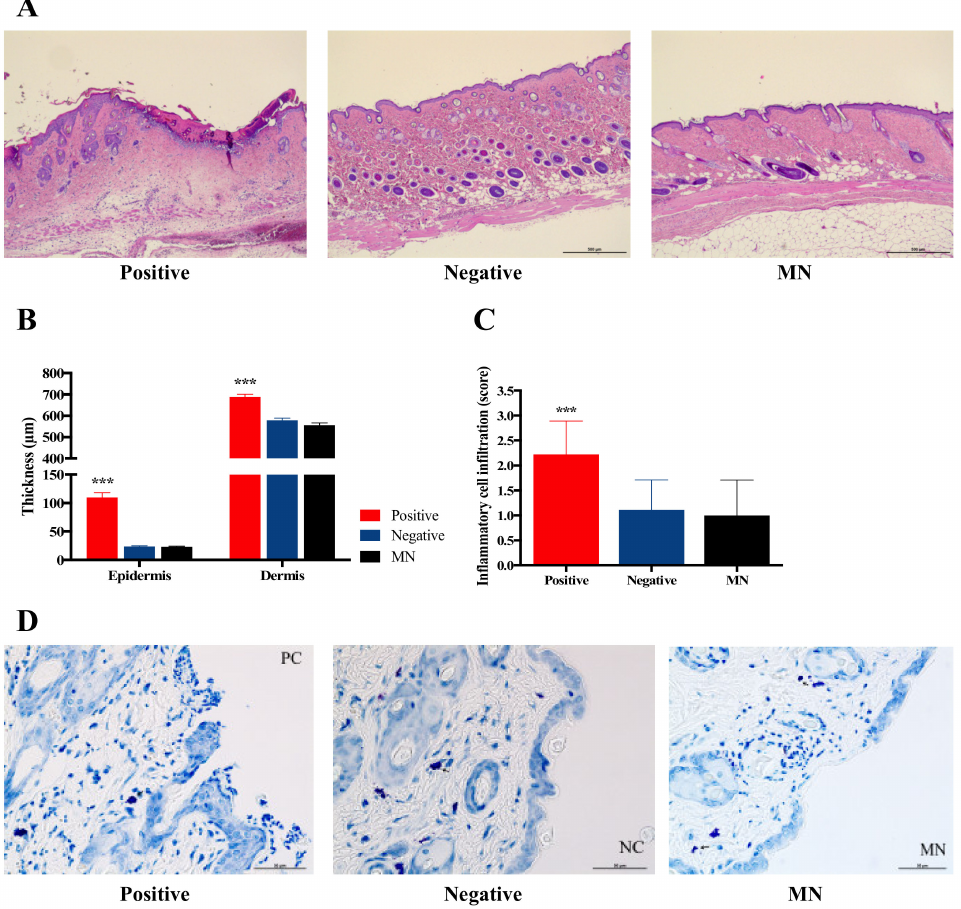
Figure 10. Representative hematoxylin and eosin (H&E) stain section of skin ( a ), the change of epidermal and dermal thickness ( b ), the score of inflammatory cell infiltration ( c ), and the infiltration or degradation of mast cells ( d ) after the application of needle (positive control), negative control and HBsAg MN, respectively. Scale bar = 500 µ